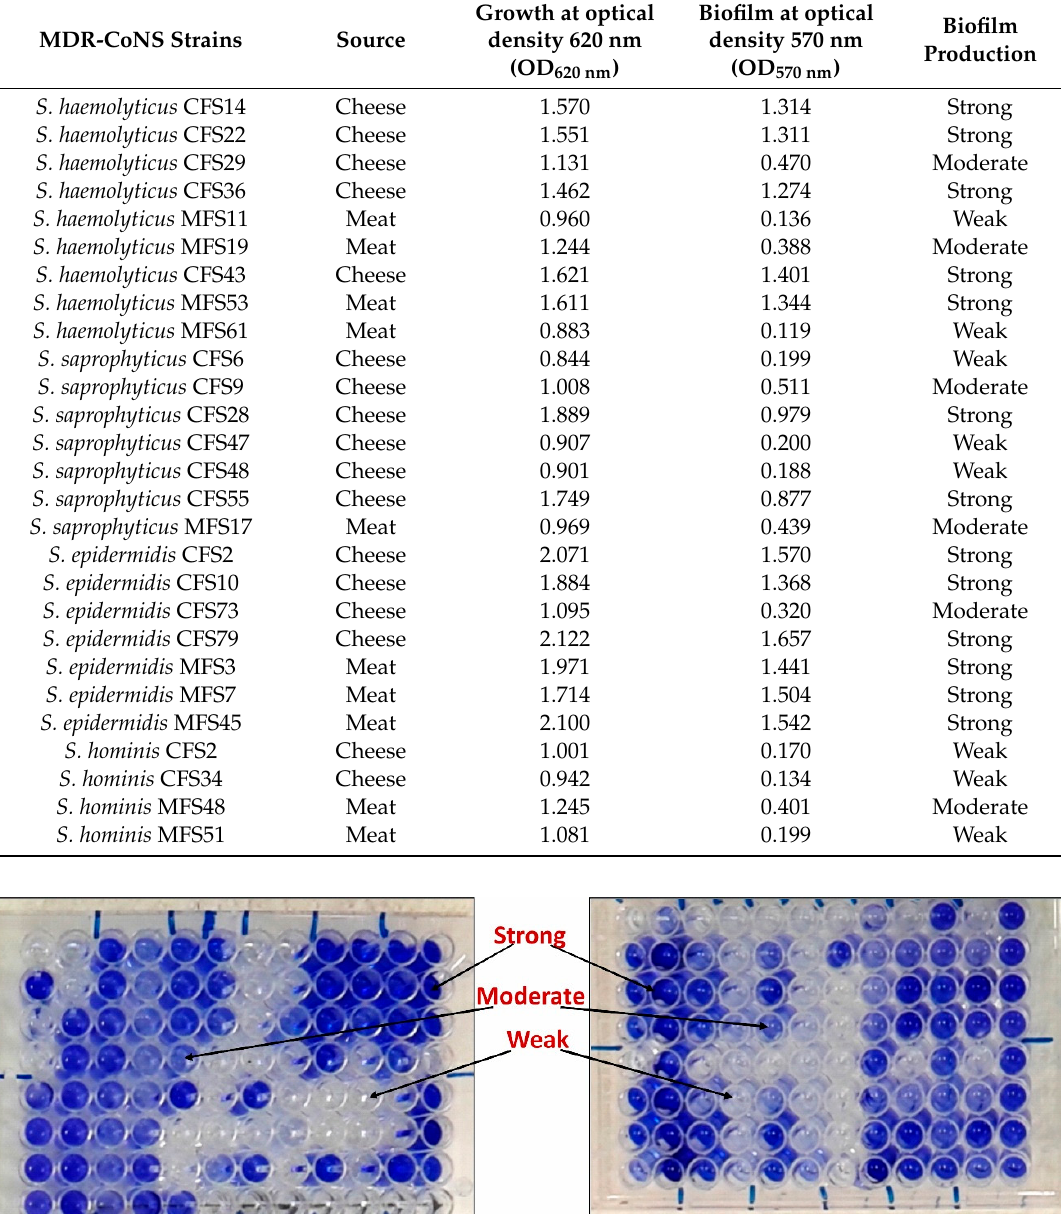
Table 1. Biofilm-forming capacity of 27 multi-drug resistant-coagulase-negative staphylococci (MDR-CoNS) strains by tissue culture plate method (TCP).